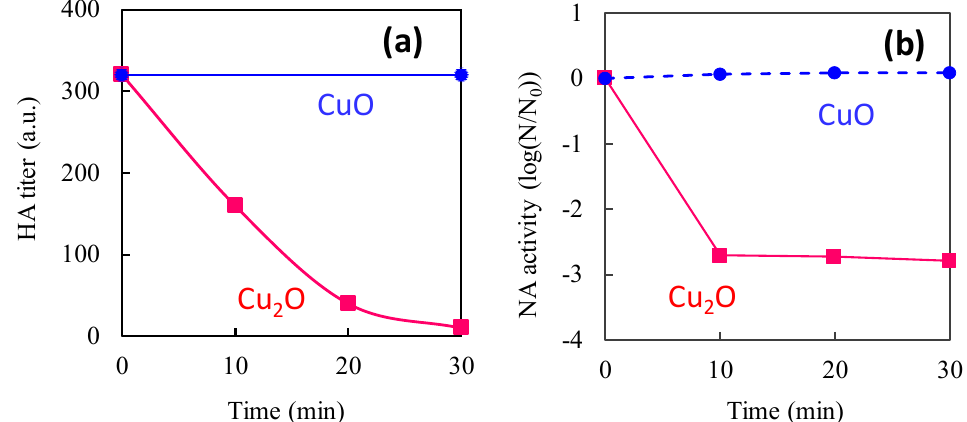
Figure 4. Hemagglutinin (HA) titer and neuraminidase (NA) activity exposed to Cu 2 O and CuO suspensions. Effect on ( a ) HA titer and ( b ) NA activity of Cu 2 O (red squares) and CuO (blue circles) as determined by a hemagglutination test and chemiluminescence using the NA-Star method, respectively. N 0 in panel ( b ) is the initial NA amount [35]. These data are based on an average of triplicate measurements.